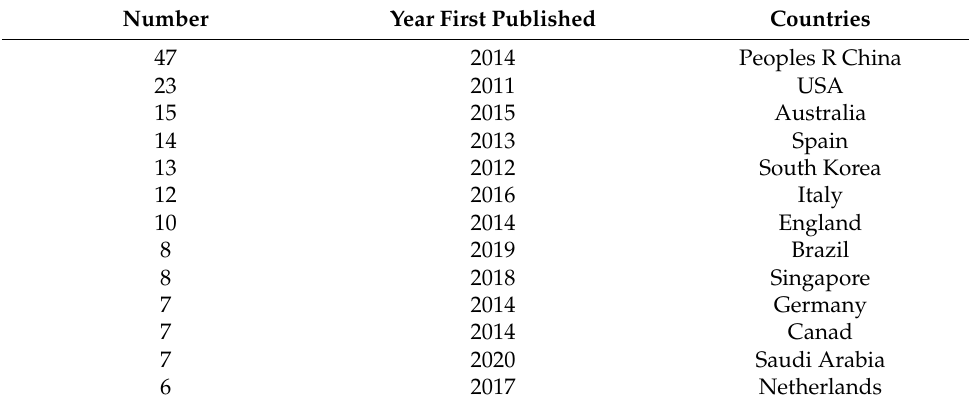
Figure 6. Journal publishing area. Table 4. Number of papers published in different countries (frequency >